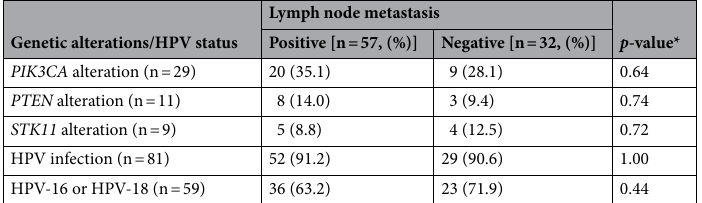
Table 4. Association between lymph node metastasis status and frequency of genetic alterations or HPV status. HPV human papillomavirus. *Fisher’s exact